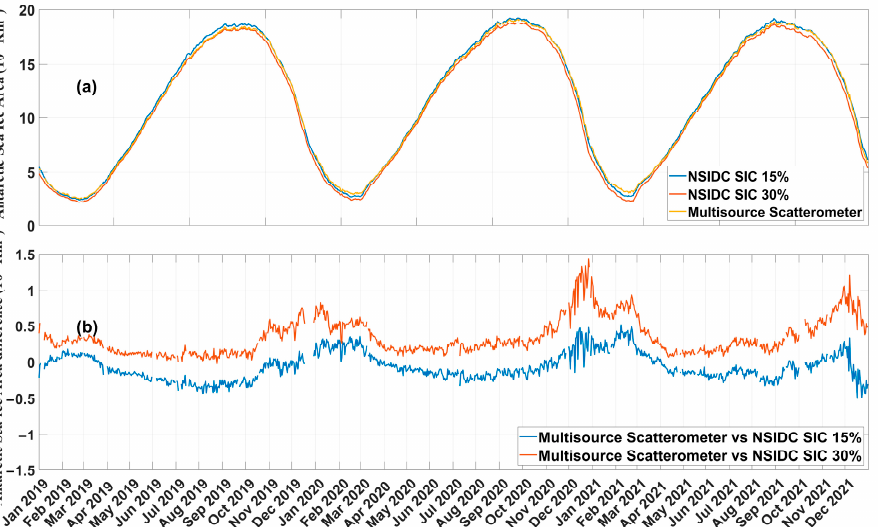
Figure 10. The validation results for the Antarctic from 2019 to 2021: ( a ) daily sea ice area for NSIDC SIC 15% ice extent (blue line), NSIDC SIC 30% ice extent (red line), and multisource scatterometer (yellow line), respectively, and ( b ) sea ice area difference between multisource scatterometer and NSIDC SIC 15% (blue line), and between multisource scatterometer and NSIDC SIC 30% (red line). Table 5. Statistics of the comparisons between multisource scatterometer and NSIDC SIC 15% and 30% sea ice extents for different periods: All refers to all data; JFM is for the months January, Febru- ary, and March; AMJ is for months April, May, and June; JAS is for months July, August, and Sep- tember; and OND is for months October, November, and December.